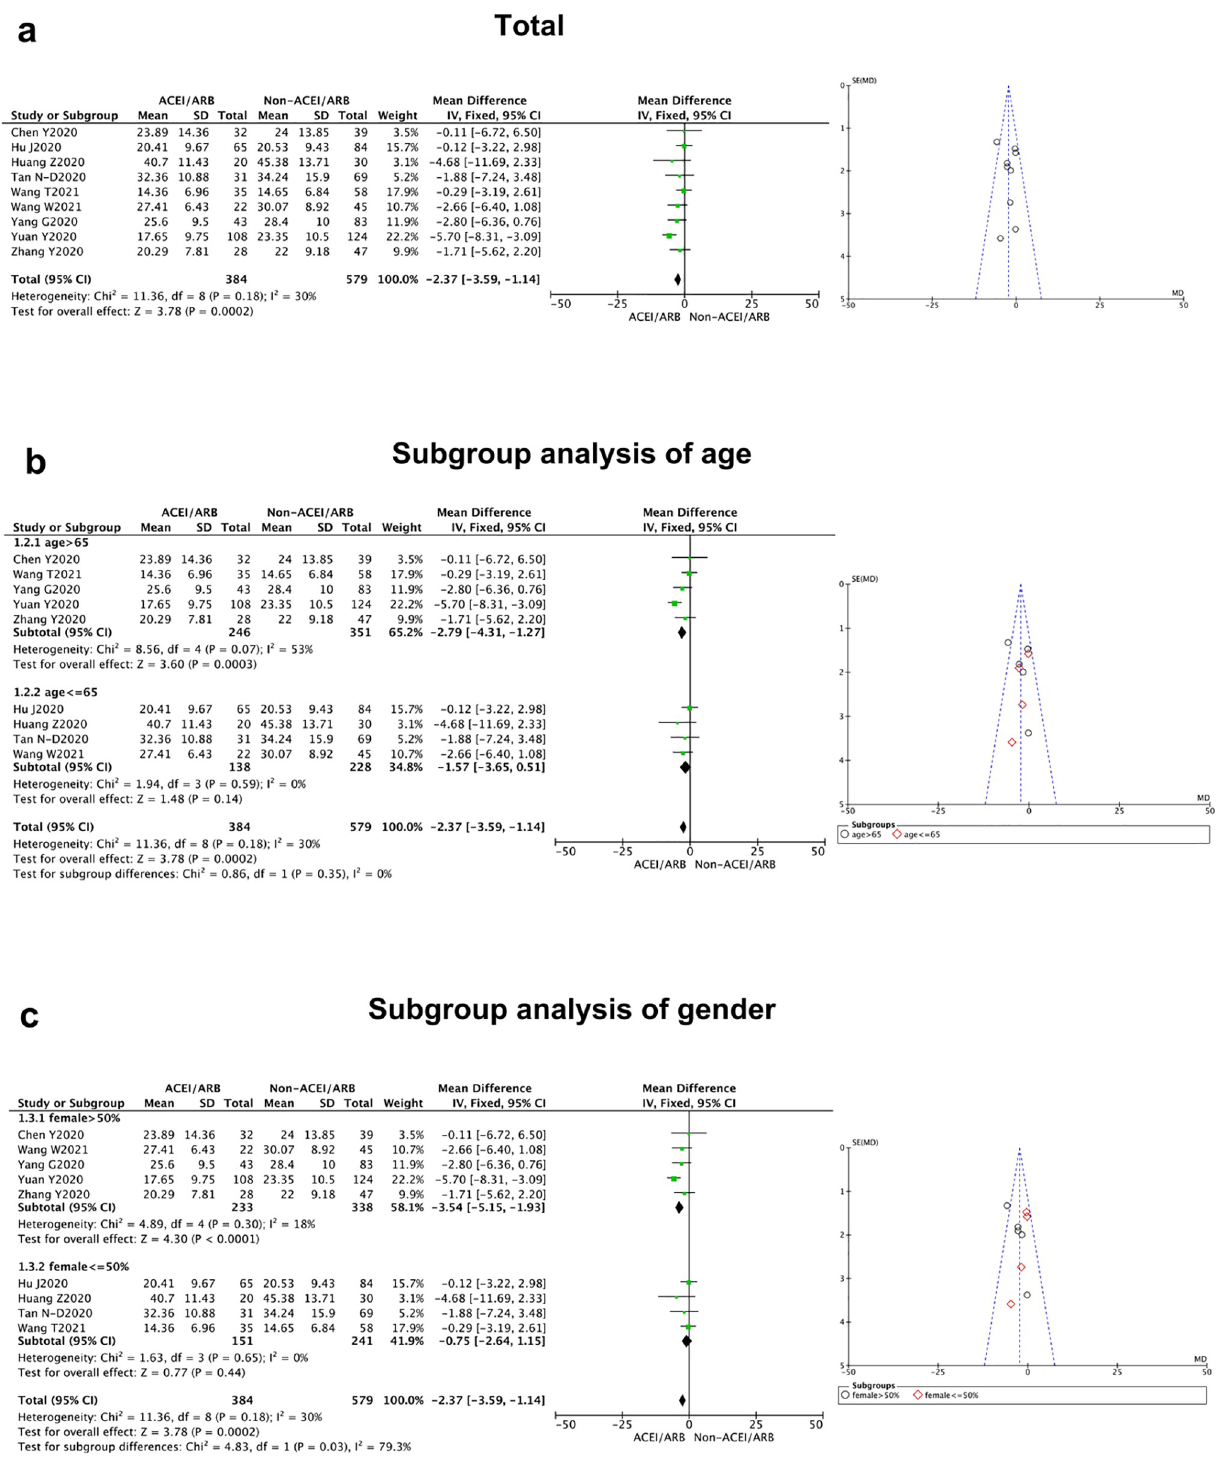
Fig 2. Duration of hospital stay of East-Asian Covid-19 patients treated with ACEI/ARB vs. untreated subjects. The duration of hospital stay data of MD and 95% CI from 9 studies were pooled in this meta-analysis and the result of metaanalysis was described as a forest plot. (a) The whole group analysis; (b)The subgroup analysis of age;(c) The subgroup analysis of gender.